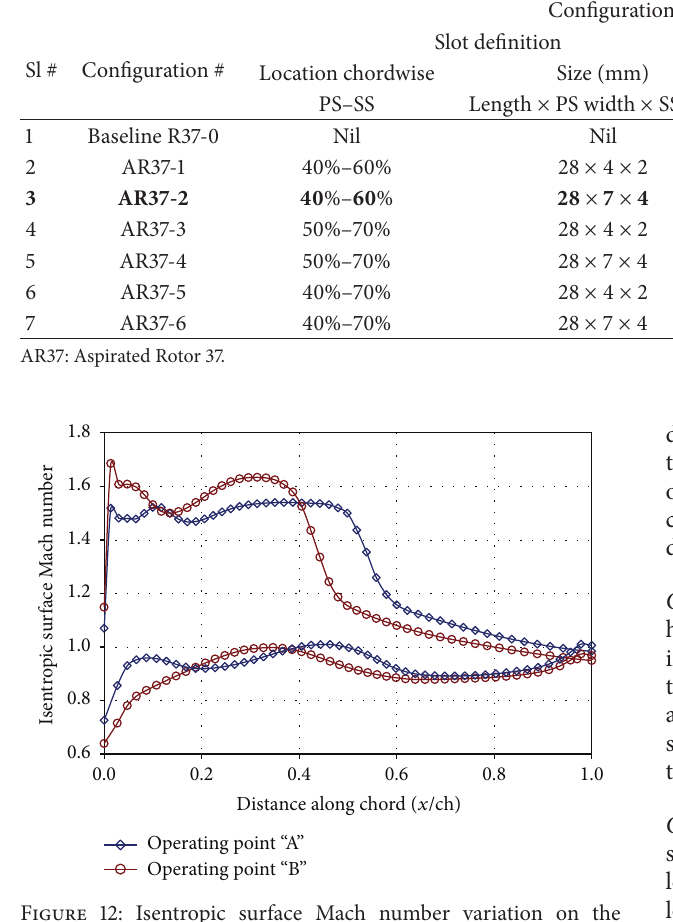
Figure 12: Isentropic surface Mach number variation on the baseline rotor at a radial location 72.5% span from hub (100% design rotational